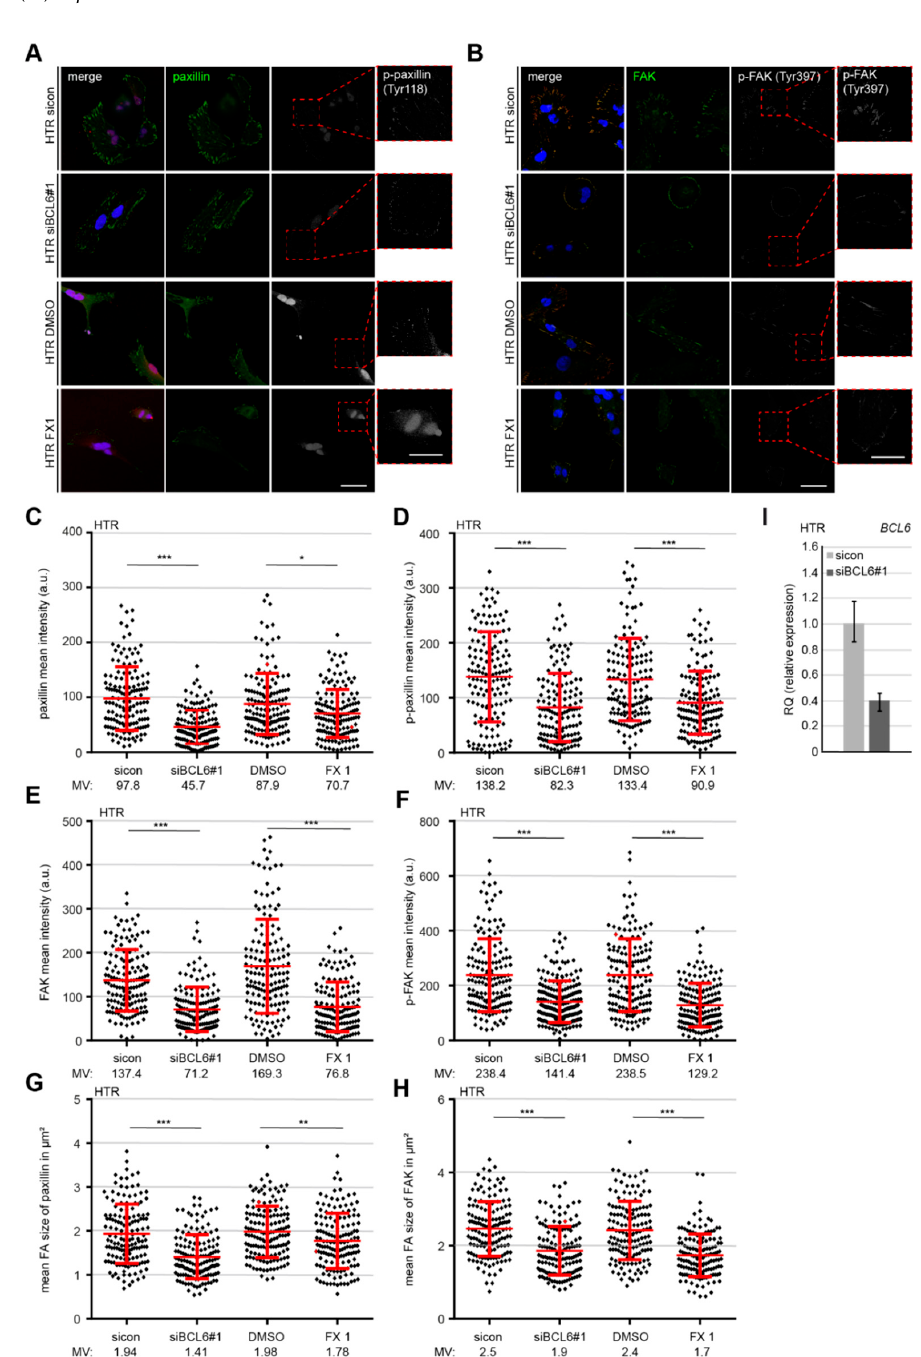
Figure 6. Reduced paxillin, p -paxillin, focal adhesion kinase (FAK), and phosphorylated FAK ( p -FAK) at FAs of HTR cells deficient of BCL6. ( A , B ) HTR cells were treated with sicon or siBCL6#1, with DMSO or BCL6 inhibitor FX1. Twenty-four hours later, cells were stained for paxillin (green), p -paxillin (white), and DNA (blue, DAPI) ( A ), or for FAK (green), p -FAK (red), and DNA (blue, DAPI) ( B ). Representatives are shown. Scale: 25. Insets are magnified regions. Scale: 20. ( C , D ) Mean intensities of paxillin ( C ) and p -paxillin ( D ) were measured (280 FAs for each condition). The results were derived from three independent experiments and are presented as scatter plots with variations. a.u., arbitrary units. ( E , F ) Mean intensities of FAK ( E ) and p -FAK ( F ) were measured (280 FAs for each condition). The results were derived from three independent experiments and are presented as scatter plots with variations. a.u., arbitrary units. ( G , H ) Mean sizes of paxillin ( G ) or FAK ( H ) in FAs were